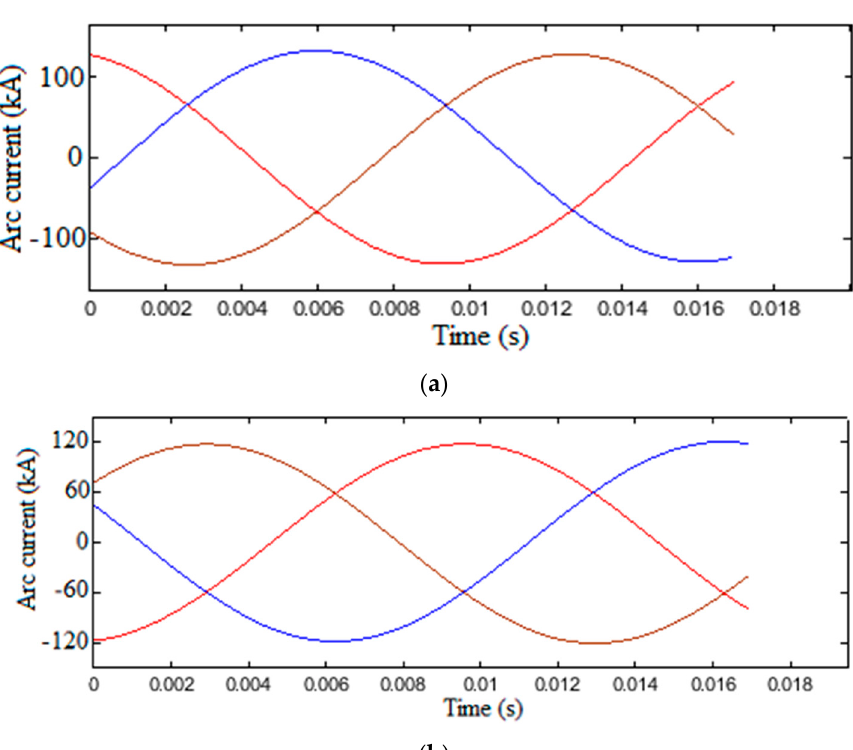
Figure 9. Waveform of arc current ( a ) Hybrid with MC, ( b ) Hybrid with MC and SVC .